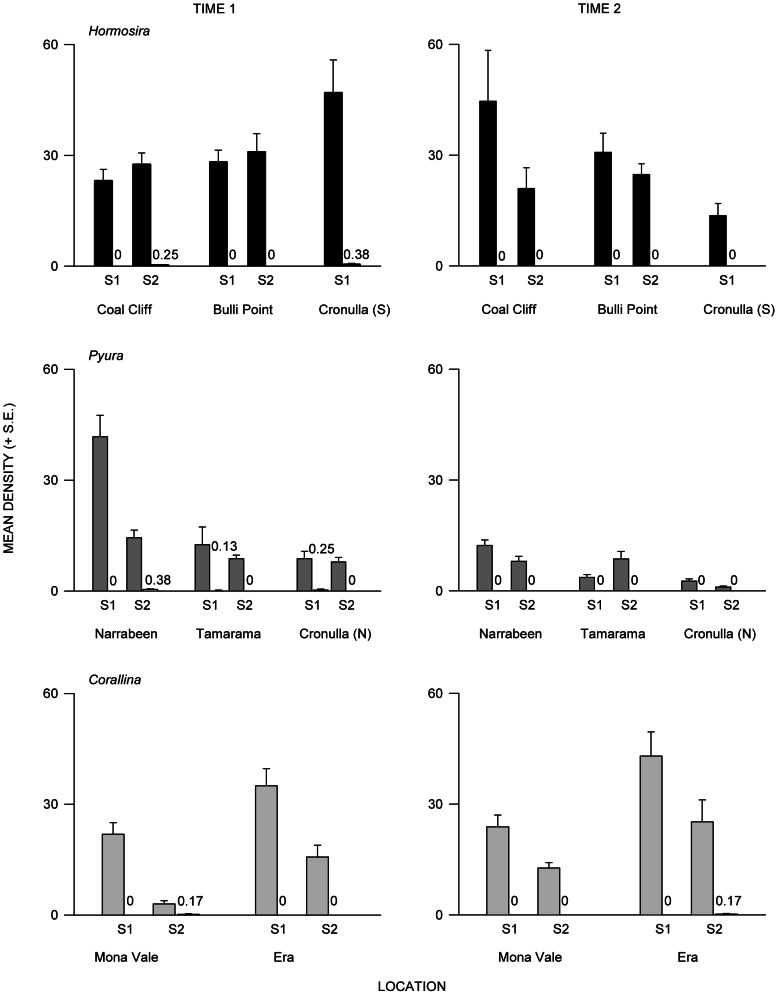
Mean density of Turbo undulatus on intertidal rocky reefs.Mean density (+ S.E.; n = 8) of T. undulatus in areas of (a) Hormosira (black bars; quadrat 0.25 m2) and non-Hormosira (white bars), (b) Pyura (dark grey bars; quadrat 0.04 m2) and non-Pyura (white bars) and (c) Corallina (n = 6; quadrat 0.25 m2, grey bars) and non-Corallina (white bars), at each location and at each time of sampling. In areas of unstructured habitat (e.g. non-Hormosira), mean density of individuals are presented above the columns, where needed, due to the small number of individuals.